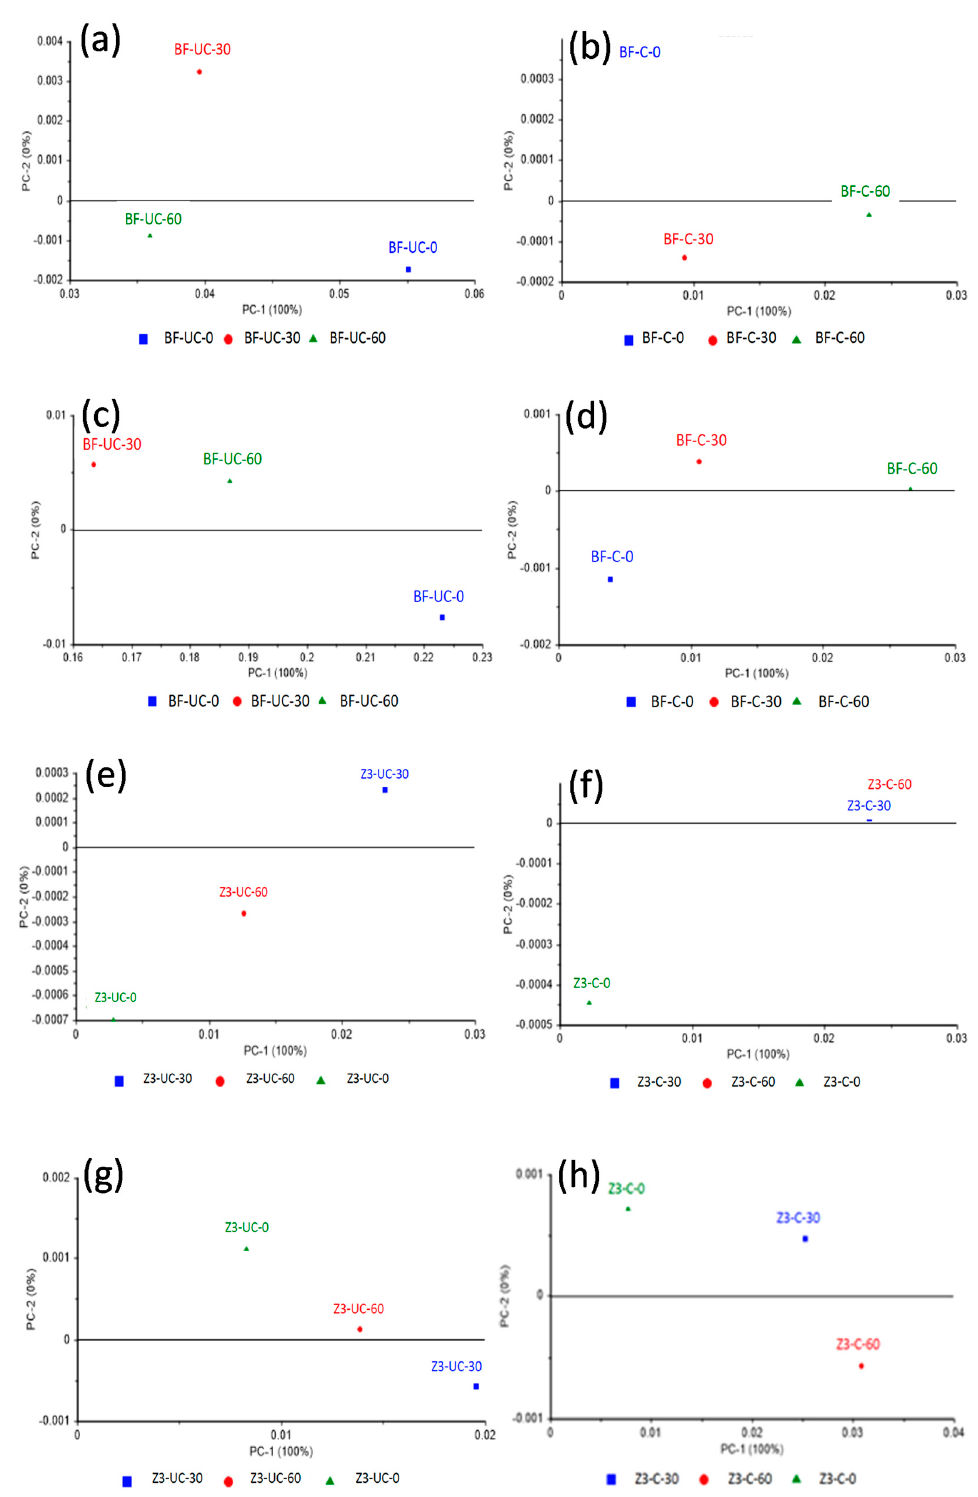
Figure 5. Principal component analysis of bulk-fill dental composite. ( a ) Uncured and ( b ) cured at spectral range 1590–1650 cm − 1 , ( c ) uncured and ( d ) cured at spectral range 1700–1750 cm − 1 . Principal component analysis of Filtek Z350 dental composite ( e ) uncured and ( f ) cured at spectral range 1590–1650 cm − 1 , ( g ) uncured and ( h ) cured at spectral range 1700–1750 cm − 1 . Both composites showed separation between control, 30 s, and 60 s of both cured and uncured phases at both the spectral ranges with 100%